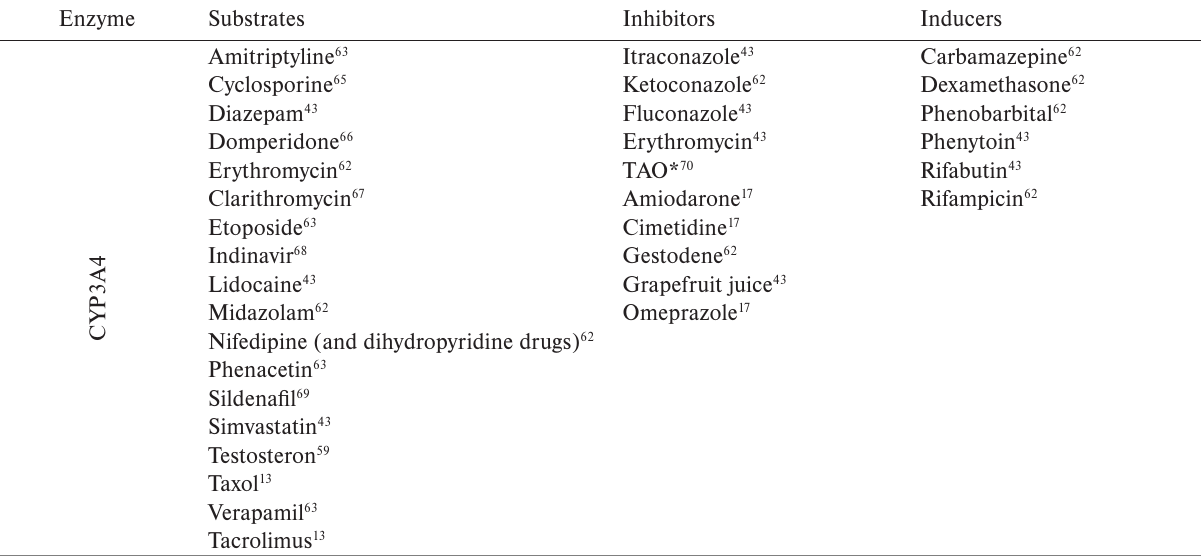
Table 3. Overview of substrates, inhibitors and inducers of the human CYP3A4 enzyme. Enzyme Substrates Inhibitors